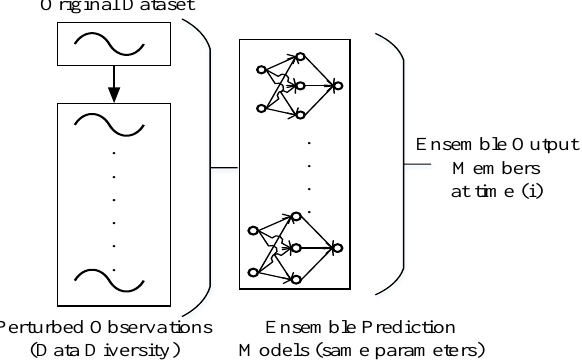
Figure 4. Data diversity ensemble forecasting diagram, where different datasets (perturbed observations) are used to train each network in the ensemble model, without changing the structure of the networks (i.e., parameters, configurations, etc.). Time (i) represents the predicted time steps.